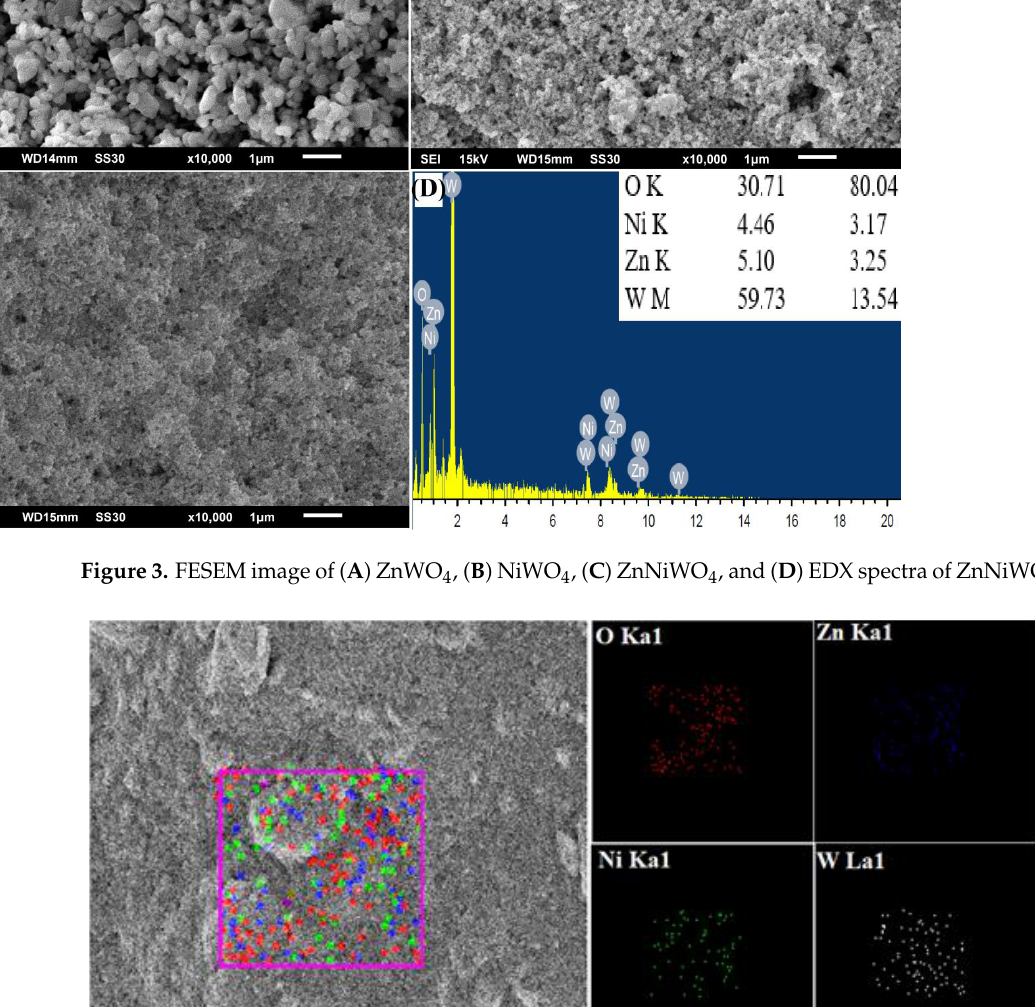
Figure 4. Selected area SEM image of ZnNiWO 4 NPs showing the mapping of O, Zn, Ni, and W. To evaluate the exact crystallite size and structure further, a transmission electron microscope (TEM) was used, and the results are given in Figure 5a,b. The TEM images of ZnNiWO 4 represented an agglomerated monoclinic crystallites ’ assembly with an average size of 16.68 nm (Figure 5c), which was also supported by the XRD results (13.67 nm). The SAED results, given in Figure 5d, also supported the Miller Indices values obtained for the XRD spectra of the ZnNiWO 4 NPs.